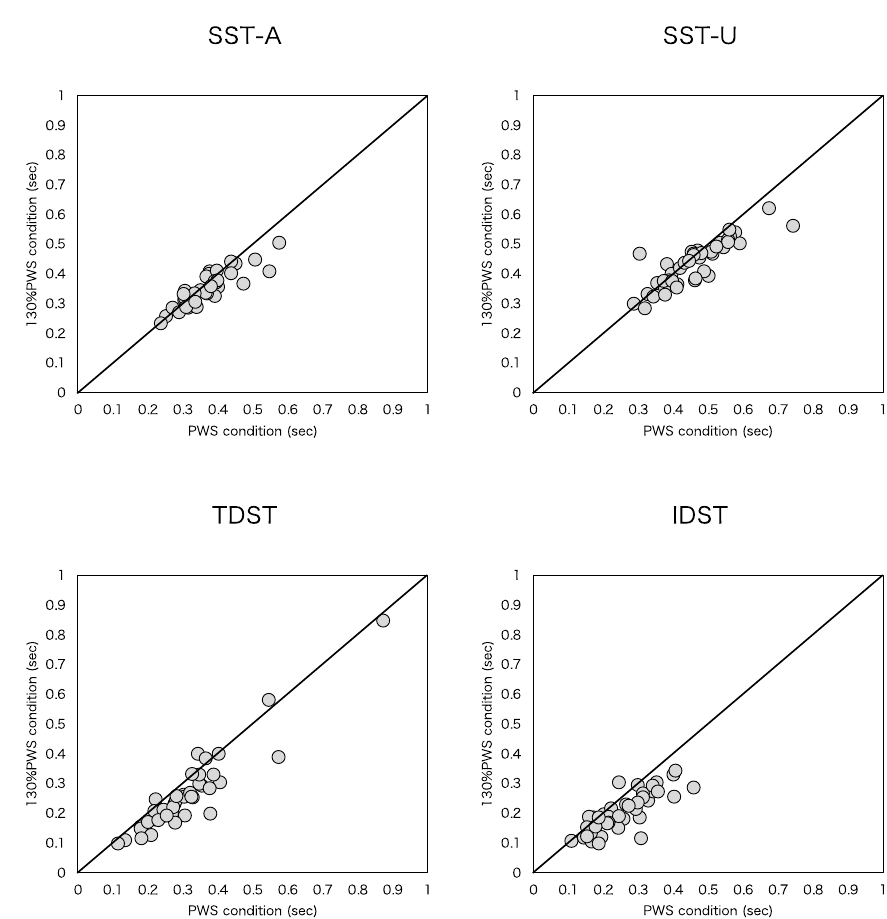
Figure 2 Scatter plot of actual time parameters for PWS condition versus 130%